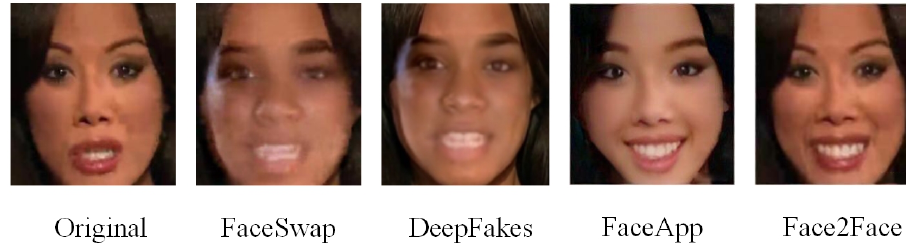
Figure 1. Face manipulated